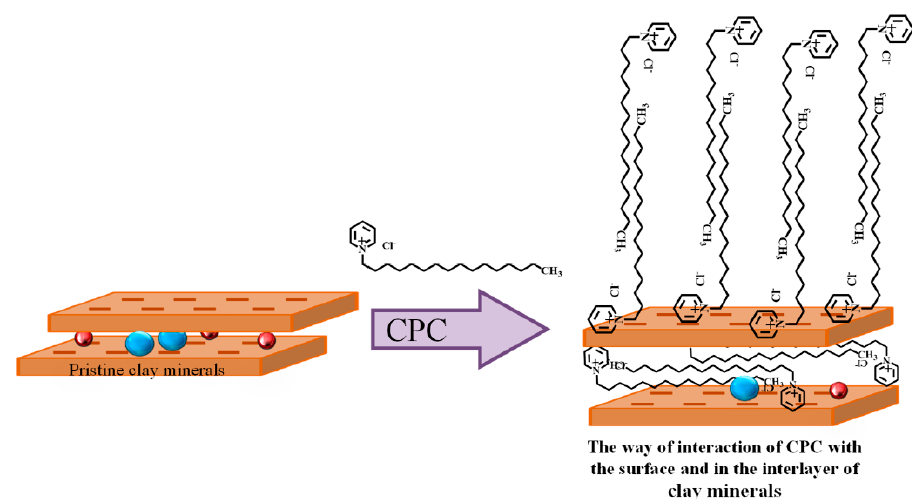
Figure 2. Possible interaction of CPC surfactant with clay minerals. Table 2. XRD diffraction peak and basal spacing of clay and modified clay.